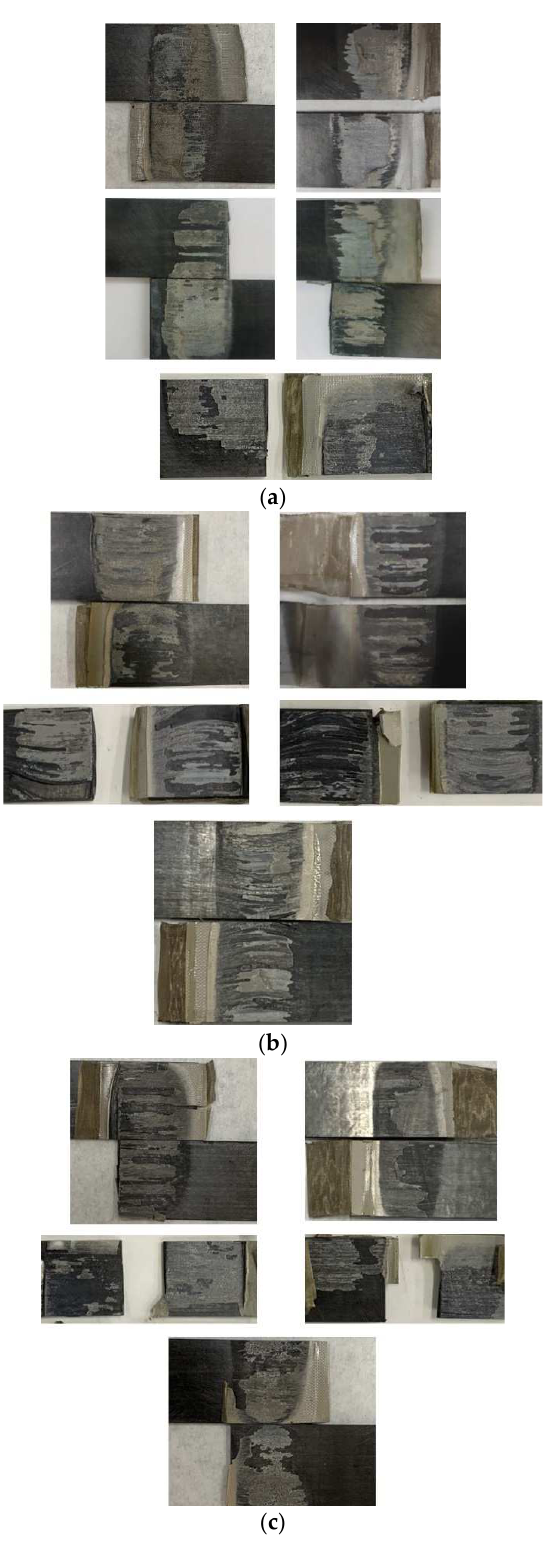
Figure A4. Photos of fracture surfaces of all welded samples obtained with different heating elements listed in Table 5: ( a ) type A, ( b ) type B, ( c ) type C.